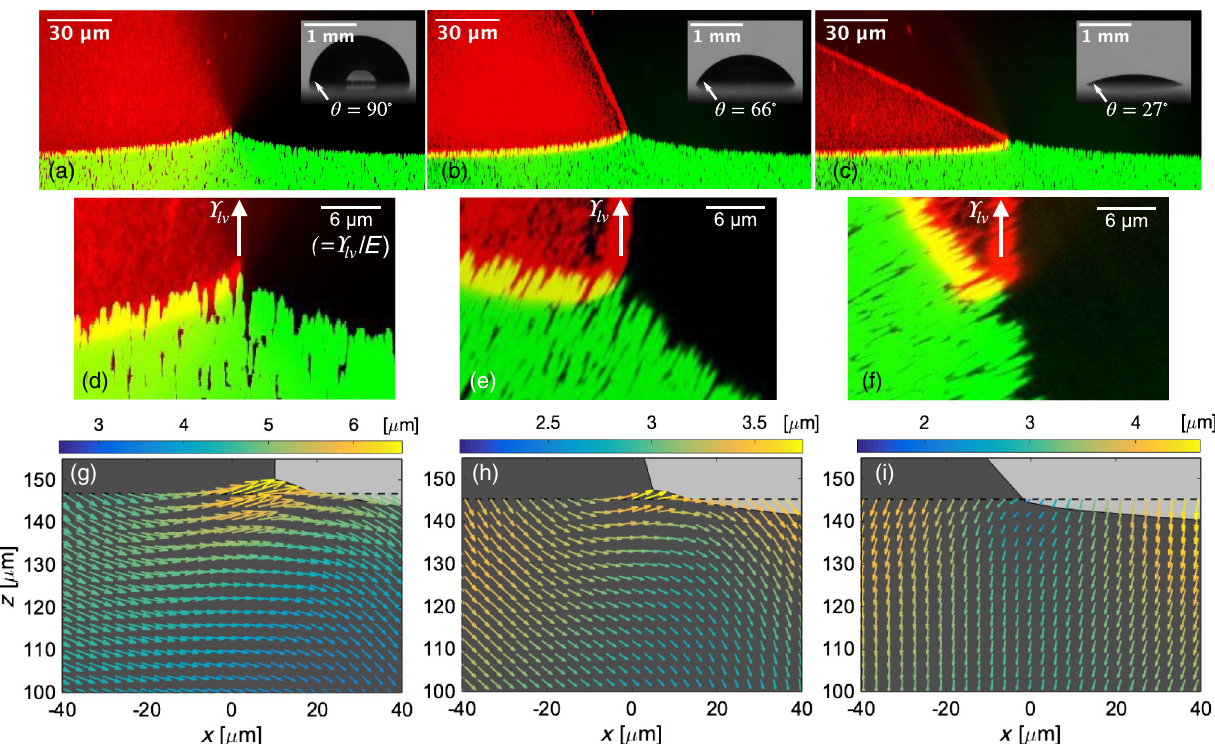
FIG. 1. Sessile glycerol-water droplets on gelatin gels swollen with the same liquid. A droplet is deposited on gelatin, where its contact line pins so that liquid can be removed without moving the contact line. (a) – (c) Side views of contact lines with different contact angles (90°, 66°, 27°, respectively) imaged with macro photography (inset) and confocal microscopy, where red (green) nanoparticles label the droplets (gelatin), respectively. (d) – (f) Enlargement of the wetting ridges in (a) – (c), rotated so that the liquid-vapor interface is vertical. Panels (g) – (i) show the displacements under the ridge, calculated by tracking nanoparticle displacements between a relaxed state where the surface is flooded with liquid and the deformed state under a contact line. The arrow colors indicate their